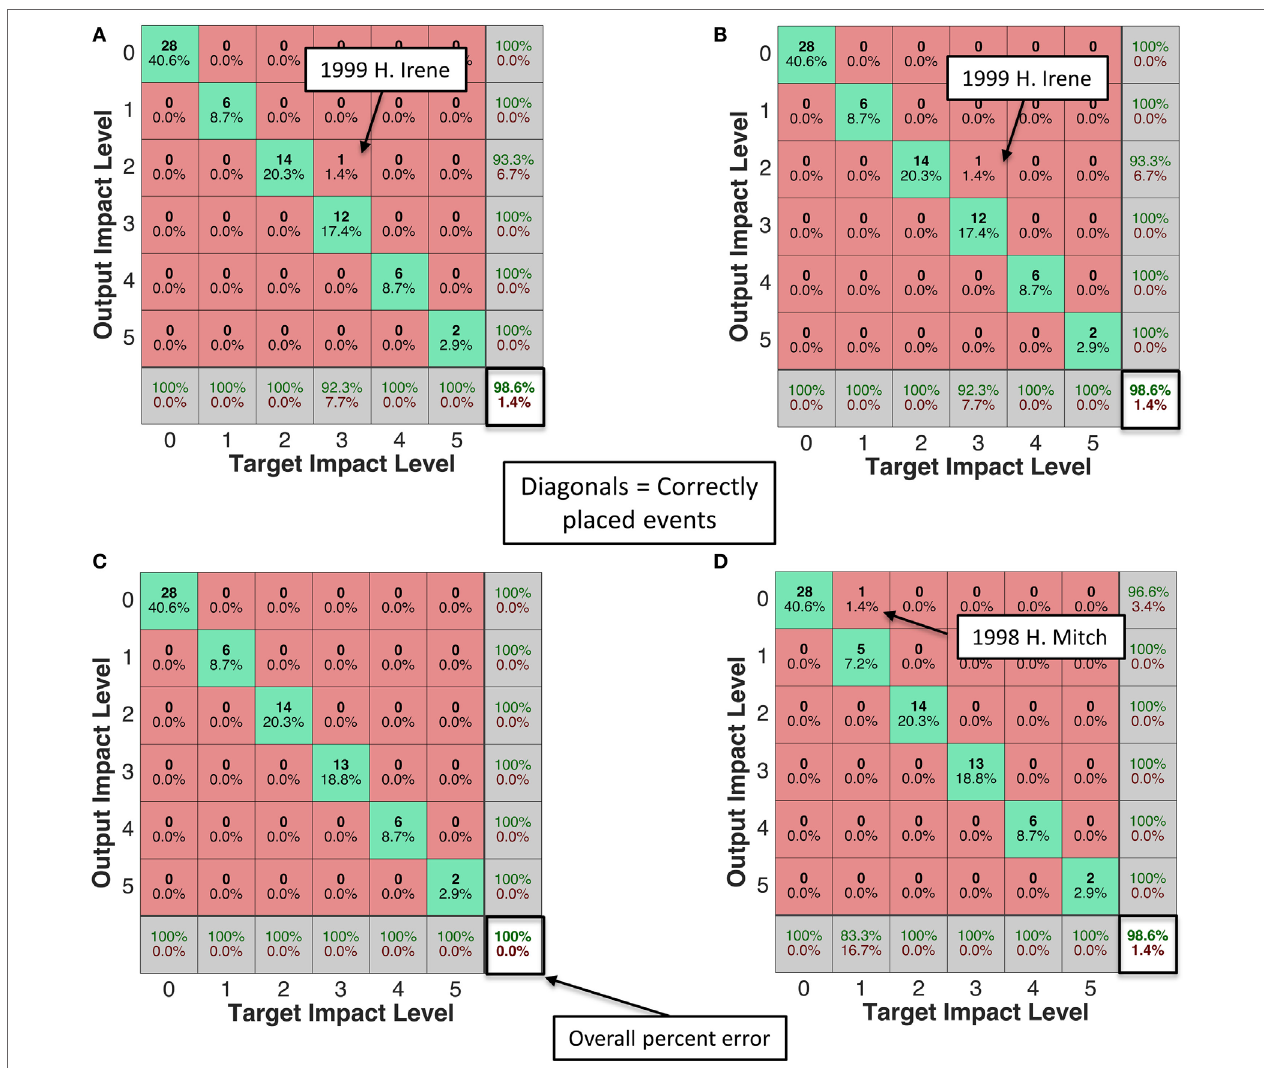
FigUre 2 | Storm event placement in building Hurricane Impact Level (HIL) Models (a) 2015a, (B) 2015b, (c) 2015c, and (D) 2015d (H = hurricane, TS = tropical